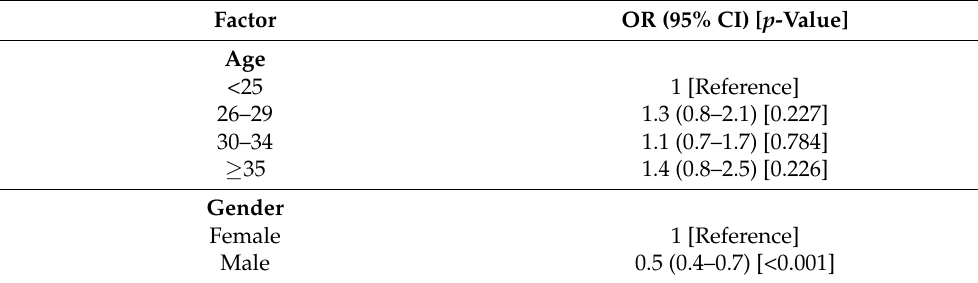
Table 3. Logistic regression analysis for factors associated with willingness to accept COVID-19 vaccine among foreigners in South Korea ( N =